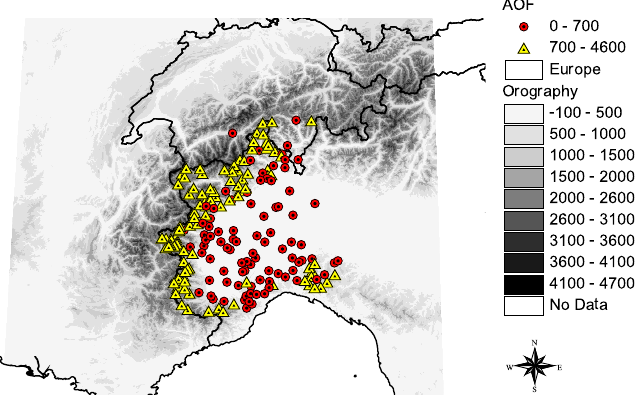
Fig. 1. Piemonte high resolution distribution for temperature sensors assimilated into the model. The red dotes indicate stations below 700m, the yellow triangles above.